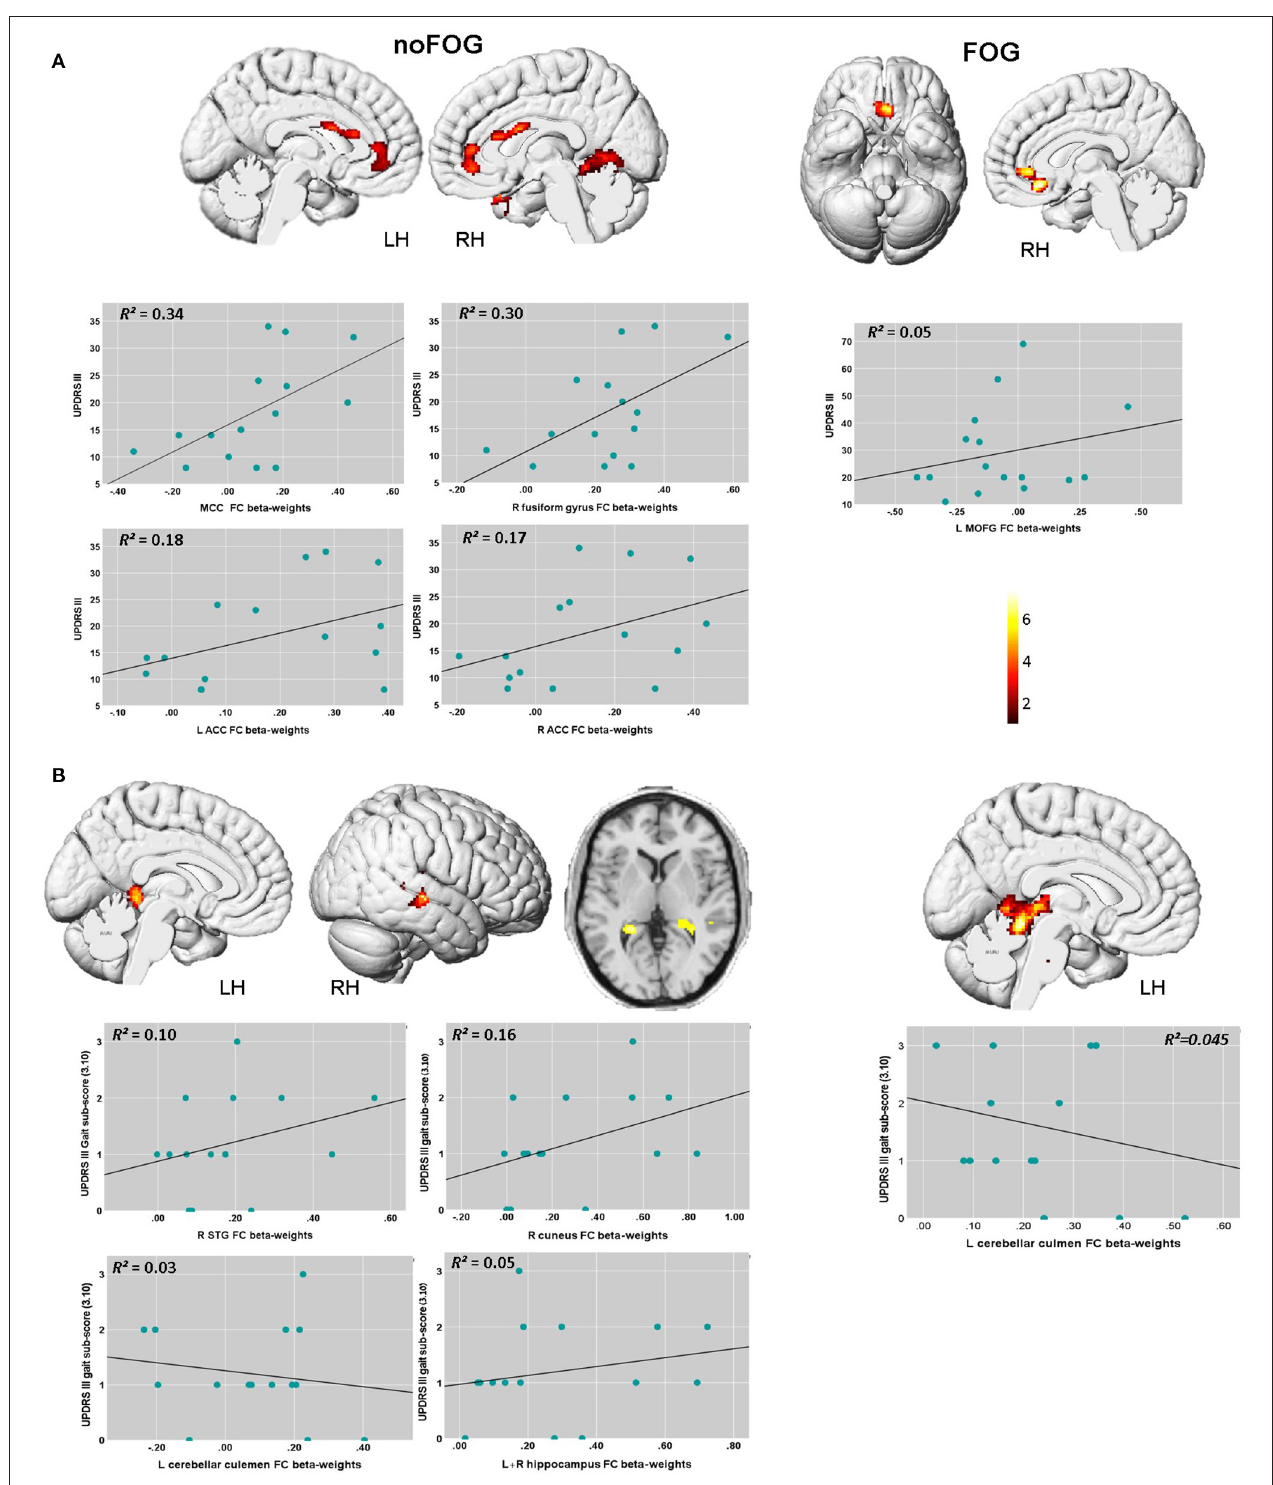
FIGURE 2 | Brain regions within the brainstem network showing significant associations between FC levels, UPDRS III total score, and UPDRS-III gait sub-score (item 3.10) based on the voxel-wise regression analysis. (A) In the PD-NOFOG group, positive association between UPDRS III total score and FC levels were detected, with higher UPDRS III score associated with higher FC levels in the MCC, the right fusiform gyrus, and bilateral ACC. In PD-FOG group, UPDRS III total score correlated positively with FC levels in theL MOFG, and the right ACC. (B) In the PD-NOFOG group, association between gait sub-score in the UPDRS-III and FC levels